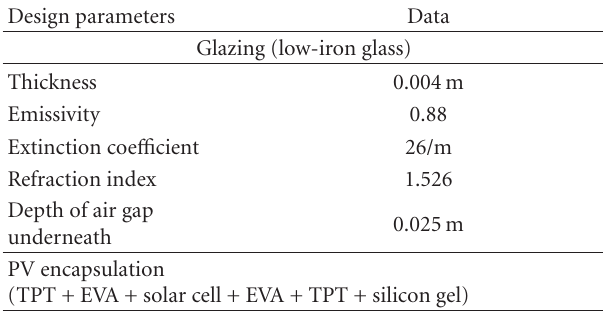
Table 1: Collector and technical design data of free-stand PV/T